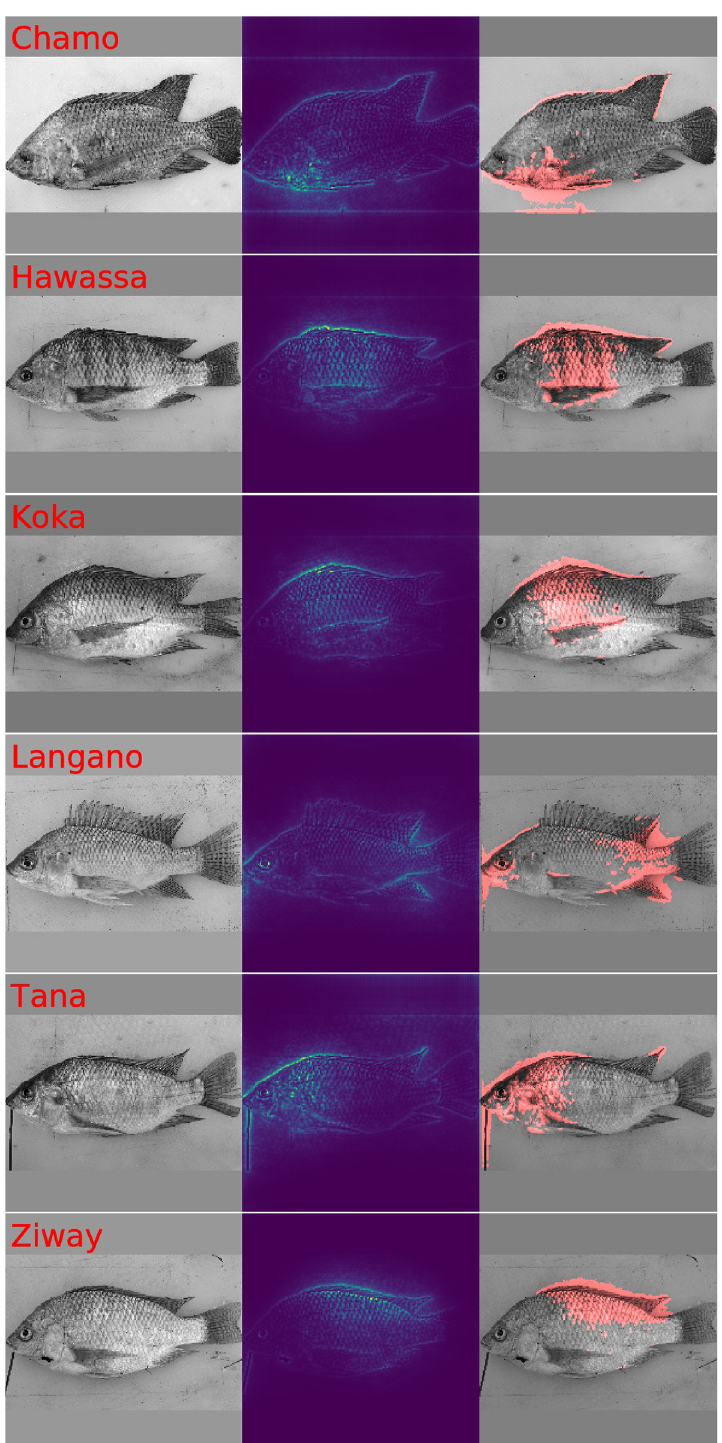
Fig 8. LPR diagnostic plots for highly representative Nile tilapia samples. This figure illustrates fish images, LPR saliency maps and diagnostic plots which display fish images and red color mask to highlight image features which contribute significantly to the prediction. The chosen samples are highly representative for the respective lake of origin. While the predictions of the samples for lakes Hawassa, Koka and Ziway are fine, the predictions for lake Chamo and Langano use information in the image background. The prediction of the lake Tana sample is aided by the presence of the fixation pin.